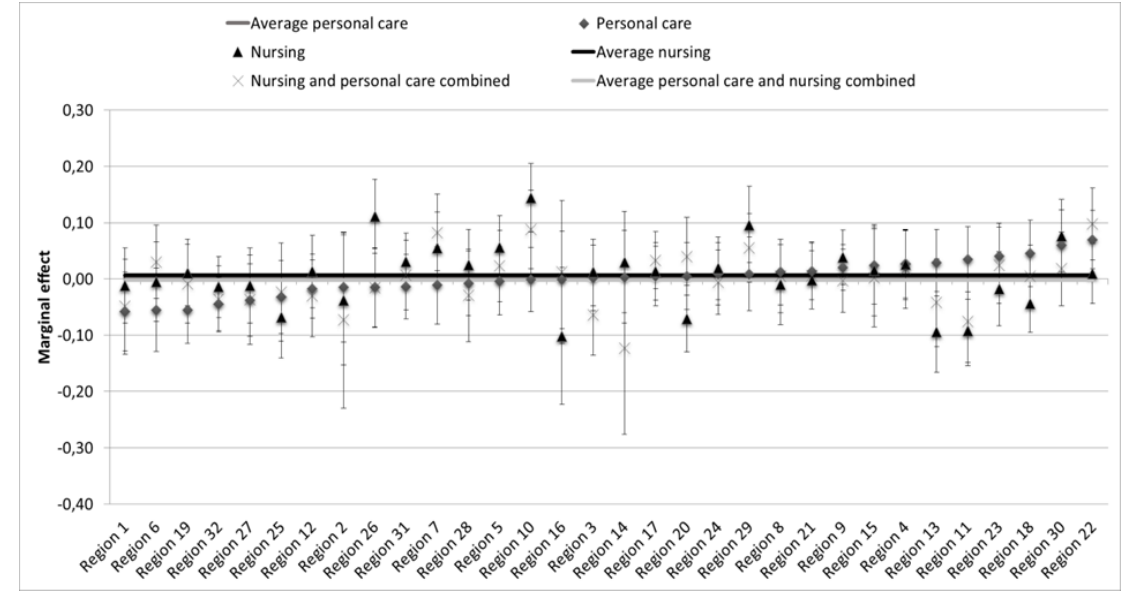
Figure 3.2: Variation in the personal care entitlements granted regarding nursing and personal care and nursing combined younger than